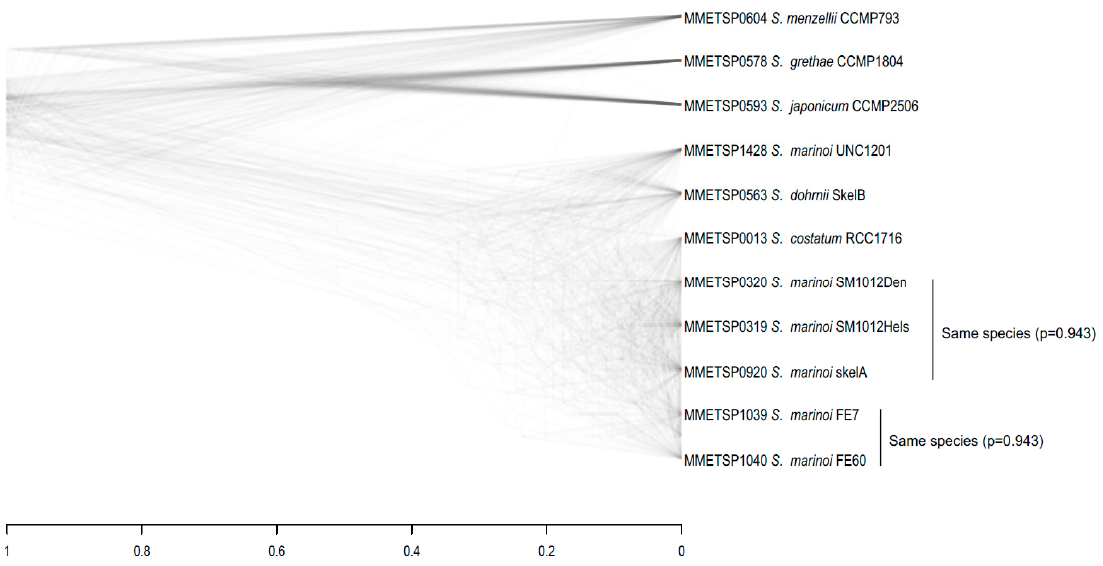
Figure 3. DensiTree of the 125 orthologs in Skeletonema genus. The two species assignments come from the A11 analysis with posterior probabilities [40,41] .